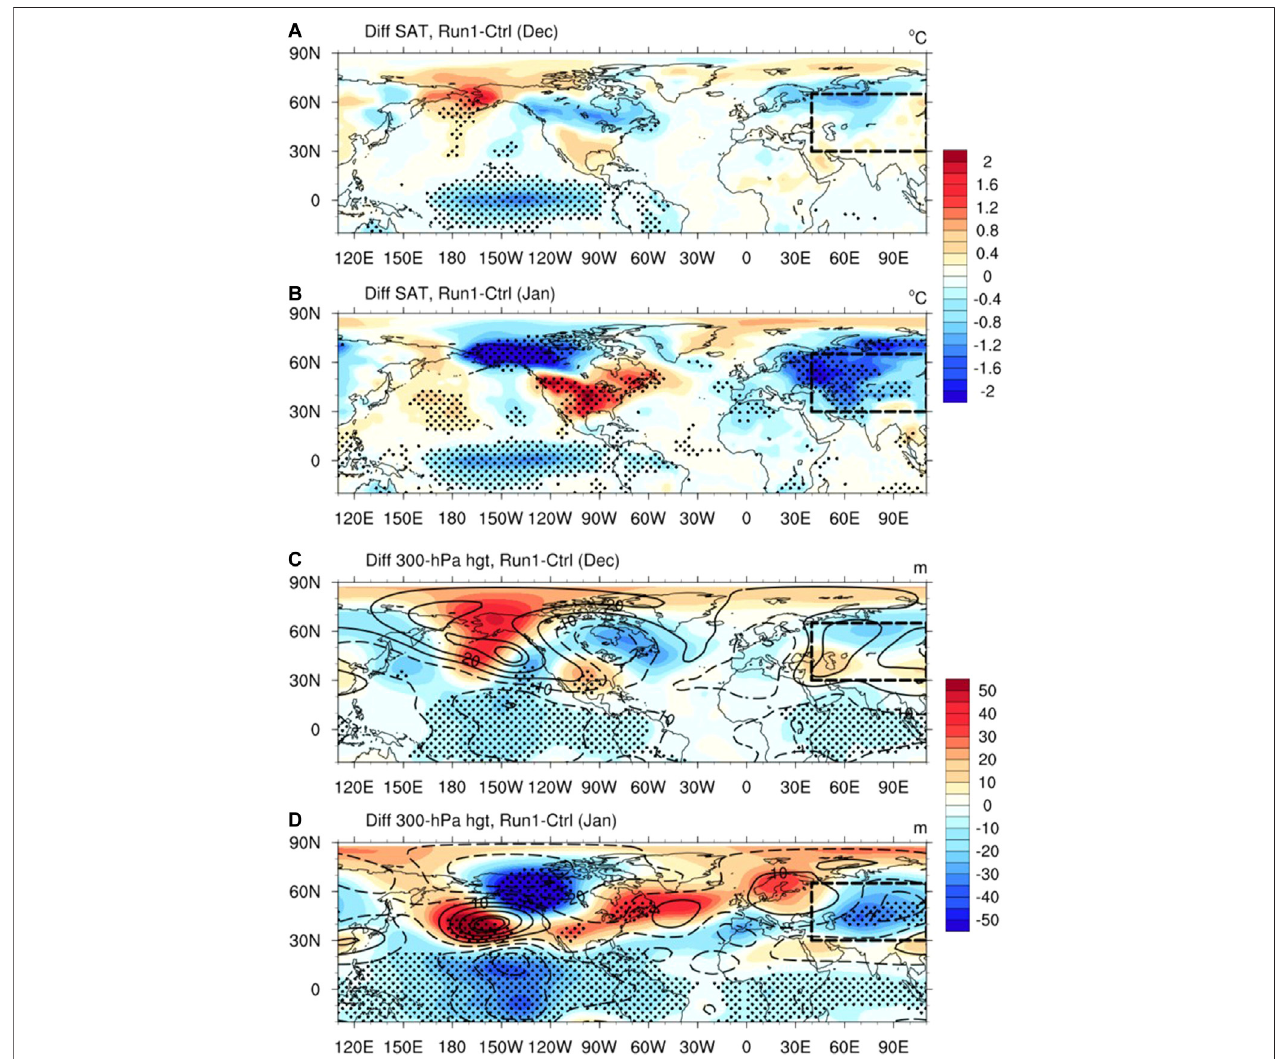
FIGURE10| Compositedifferenceinthe (A) DecemberSAT(shading; ° C)and (C) geopotentialheight(shading;m)betweenRun1andCtrl (B,D) Asin(A,C)butfor January. The contours in (C, D) show the regression of the 300 hPa geopotential height onto the − Niño4 index for December during 1979 – 2017 and January during 1980 – 2018, respectively, in which zero contours are omitted and negative values are dashed. The black dashed boxes show the region of CA; anomalies signi fi cant at the 95% con fi dence level are denoted by dots, as estimated by the Student ’ s t -test.